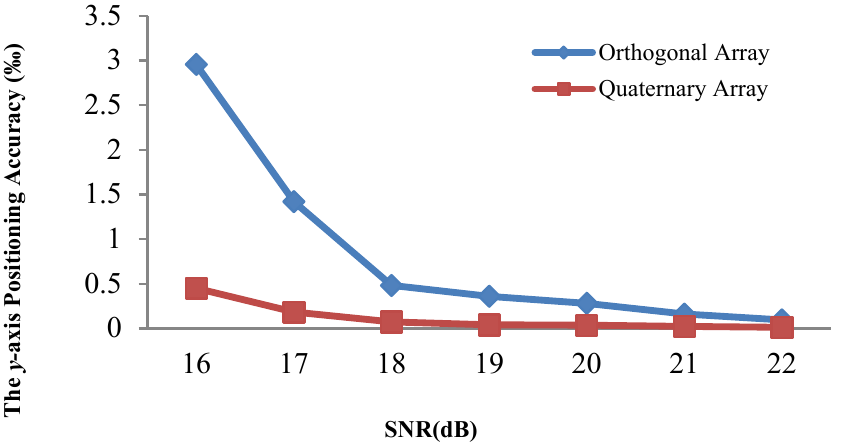
Figure 14. Comparison of the y -axis positioning accuracy of the adaptive algorithm for different arrays and different SNR values.